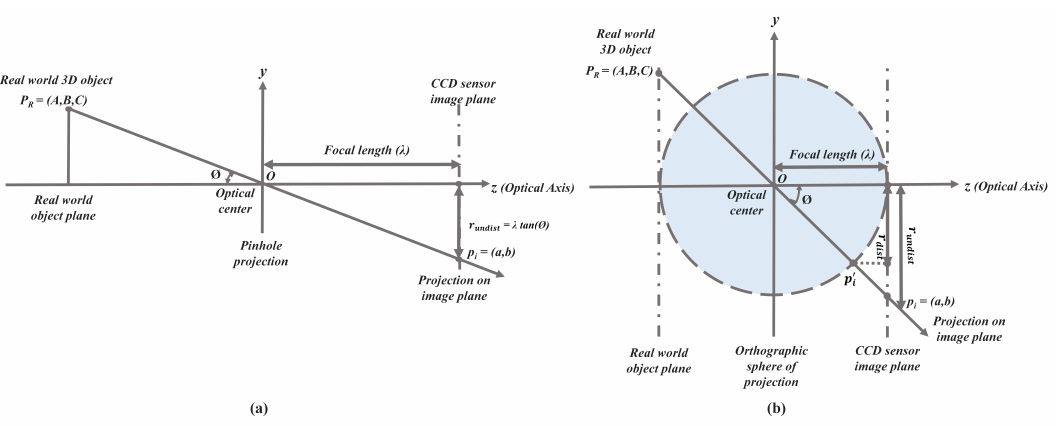
Figure 3. Lens Projection Models: ( a ) Standard Camera Pinhole Projection Model. ( b ) Larger FOV Lens Orthogonal Projection